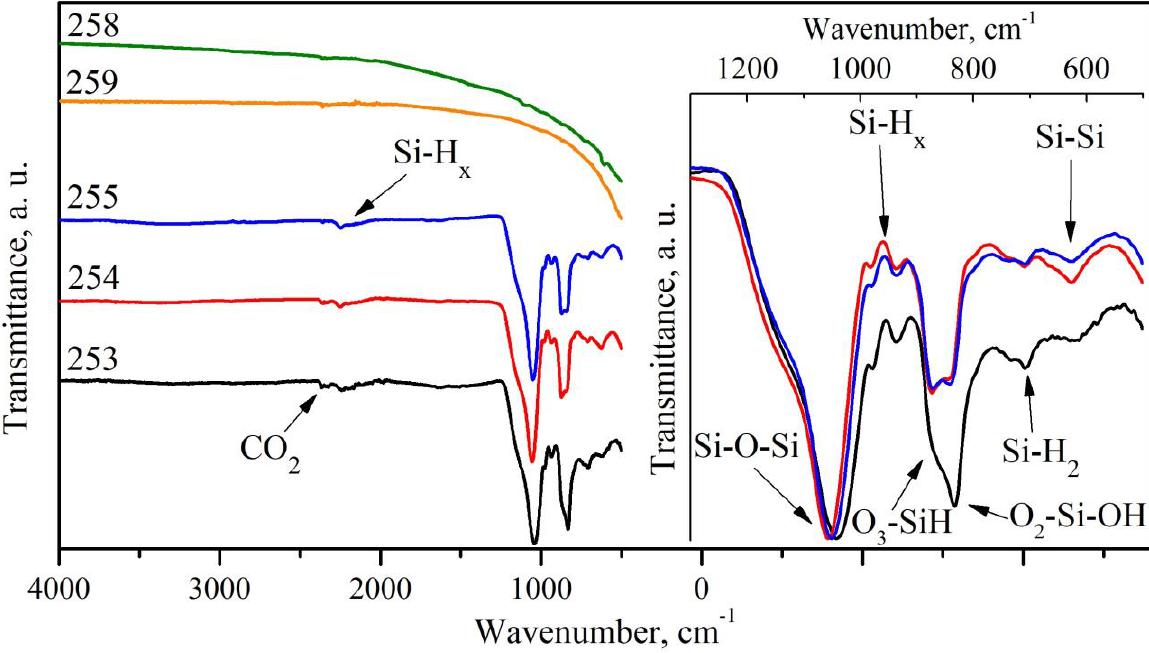
Figure 4. IR−spectra of porous silicon samples obtained by ATR technique. Figure 4. IR − spectra of porous silicon samples obtained by ATR technique.